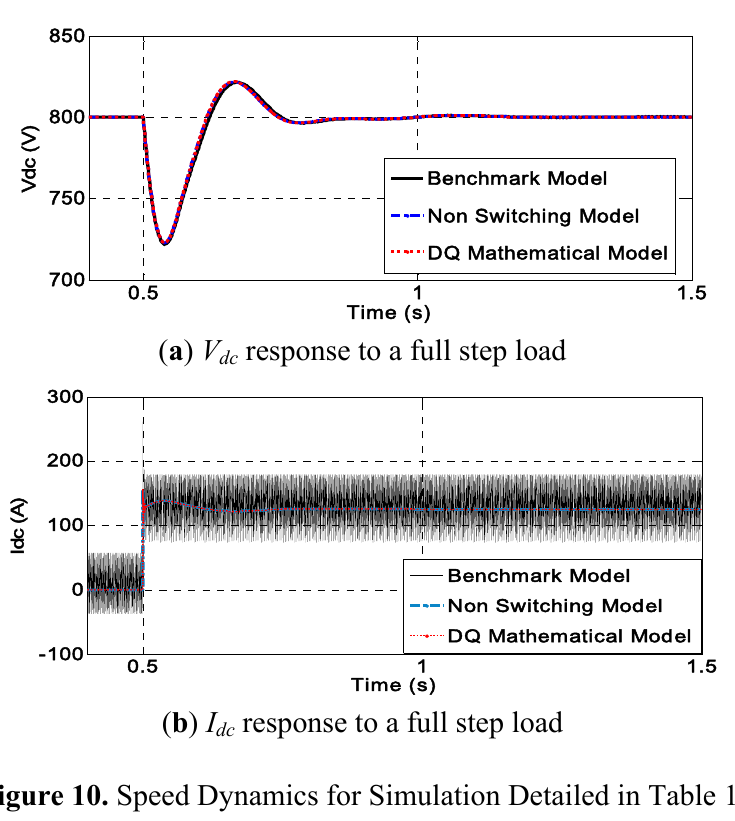
Figure 9. Further simulation results: ( a ) V a full step load.